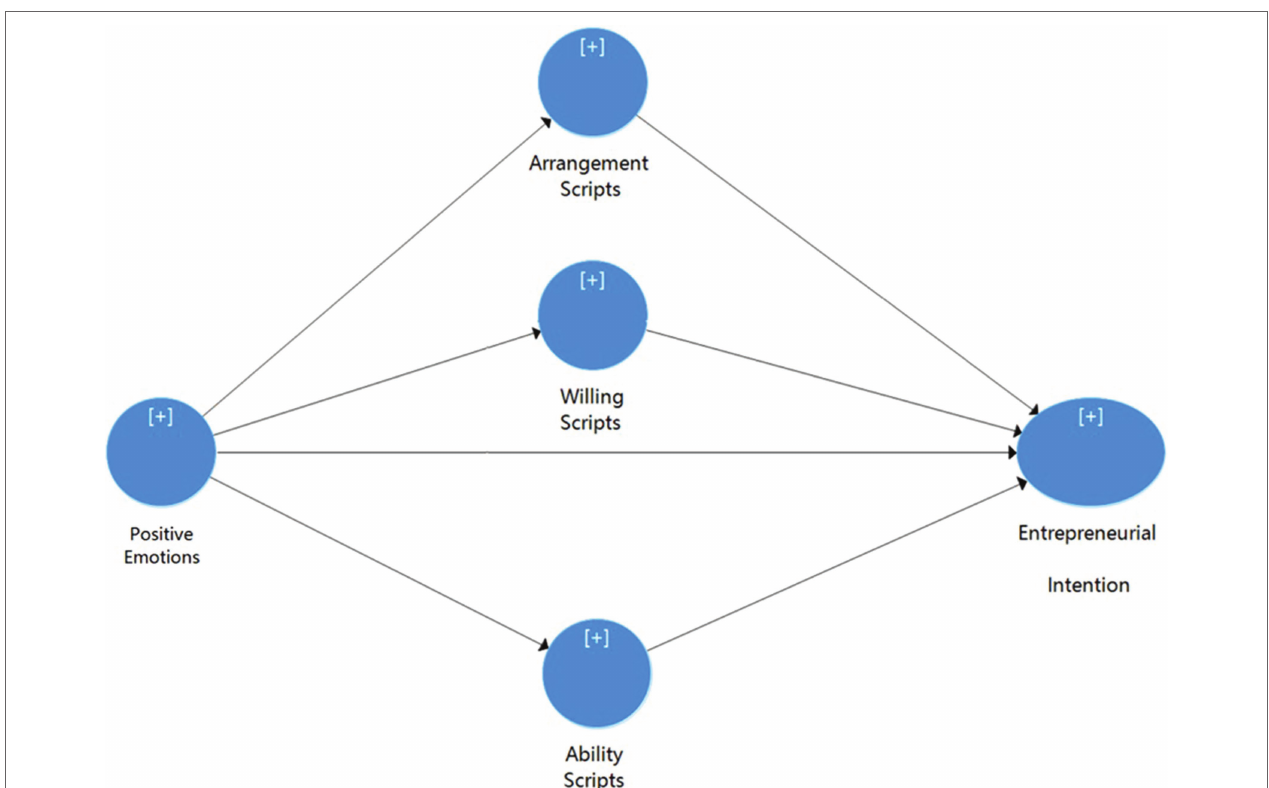
FIGURE 1 | Research